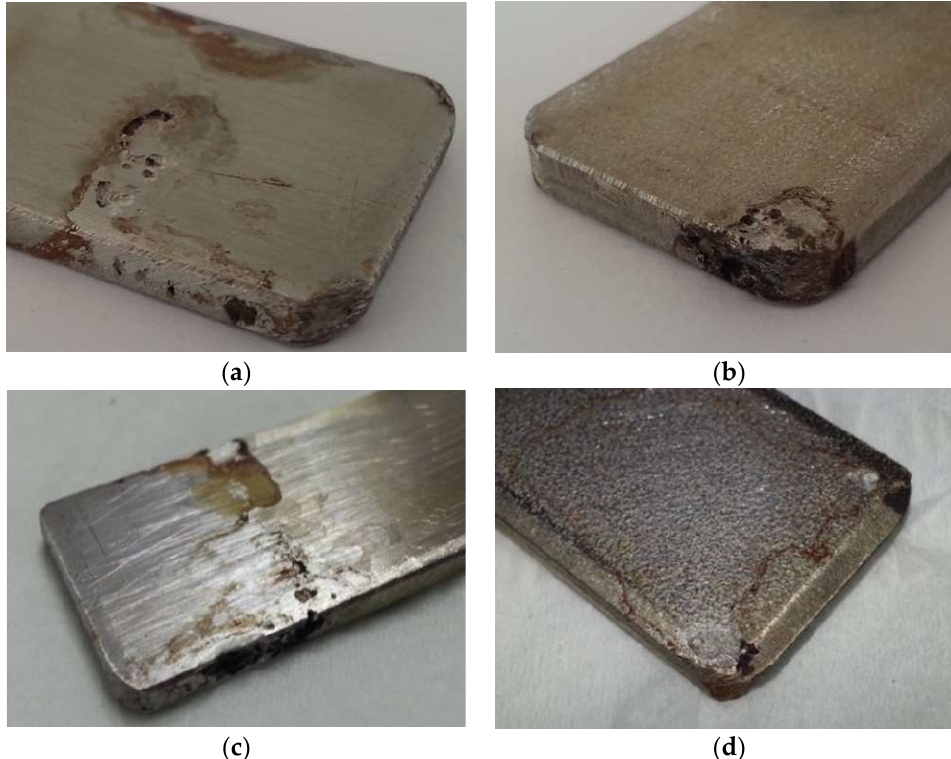
Figure 1. Dry samples of AISI 316L and AISI 321 after three weeks ( a , b ) and three months ( c , d ).